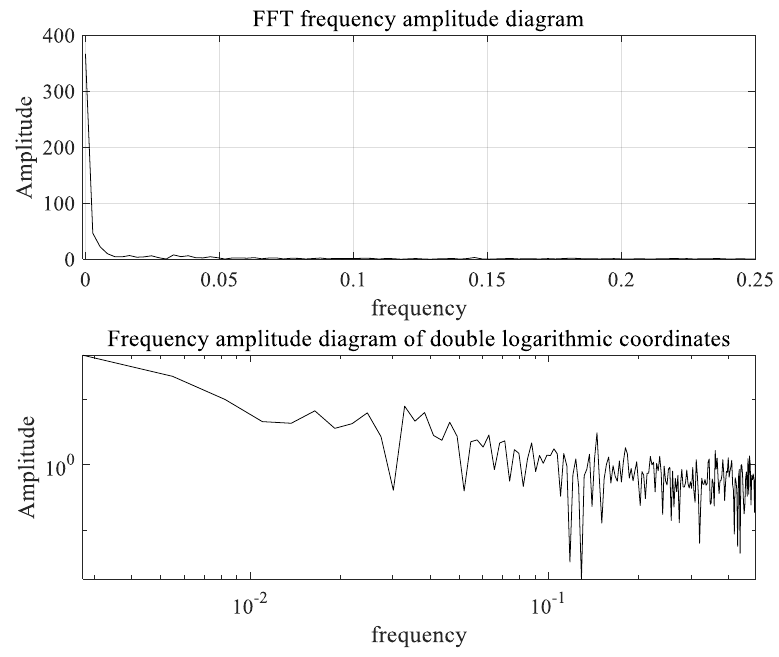
Figure 5. Fourier transform analysis . (Note : since the frequency points with large amplitude in the frequency amplitude diagram of the original demand signal obtained by Fourier transform are not obvious, the frequency amplitude diagram under double logarithmic coordinate is selected for analysis.)